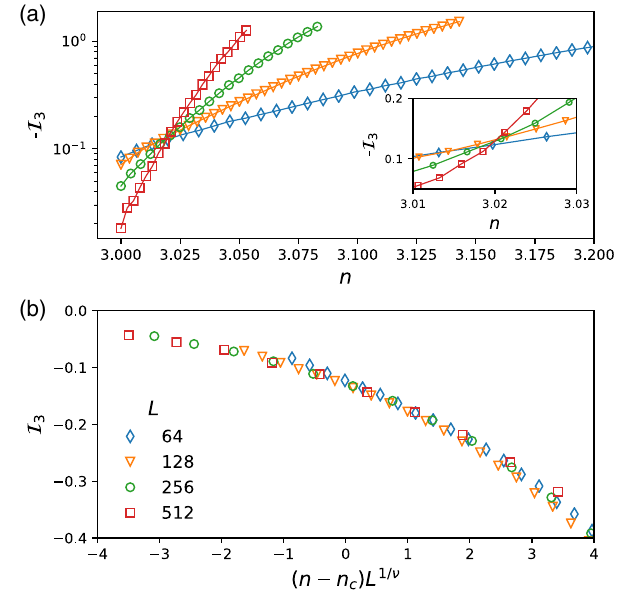
FIG. 12. Entanglement transition in the l -bit MOM continued to “ fractional n ” between 3 and 4. (a) Tripartite mutual informa- tion I 3 as a function of n . Different sizes 64 ≤ L ≤ 512 show a 3 . 020 ð 3 Þ (inset). (b) Scaling collapse of the crossing at n ¼ n c ¼ data with exponent ν ¼ 1 . 1